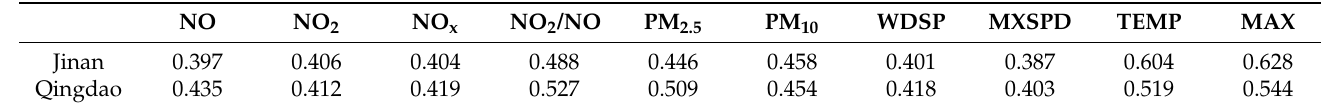
Figure 6. Wavelet power spectrum of O 3 . The left axis is the period (days), the bottom axis is time (days). The thick contour enclosed regions of greater than 95% confidence for a red noise process, the cone of influence where edge effects might distort the picture is shown as a lighter shade. The legend on the right shows the intensity of the wavelet power. Table 2. ARsq (wavelet coherence coefficient) of meteorological conditions and other air pollutants with O 3